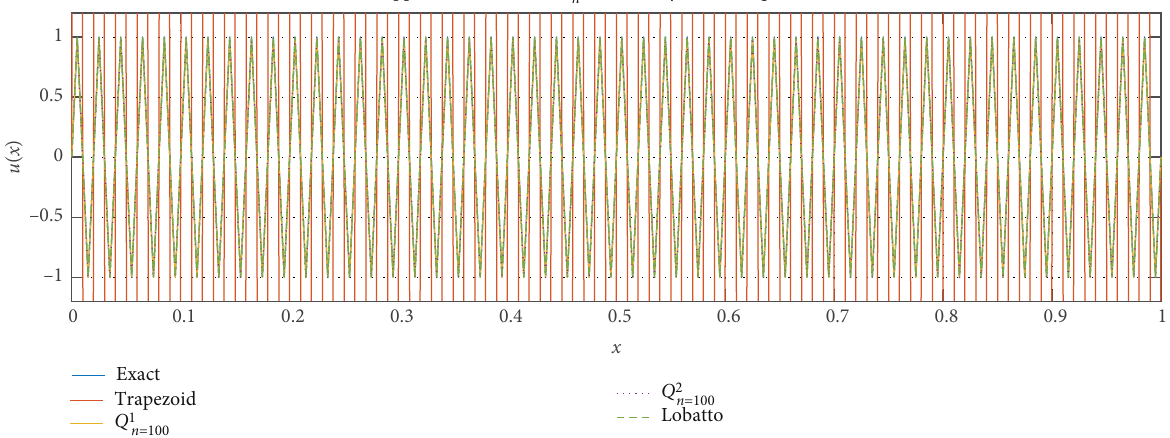
Figure 7: Exact solution